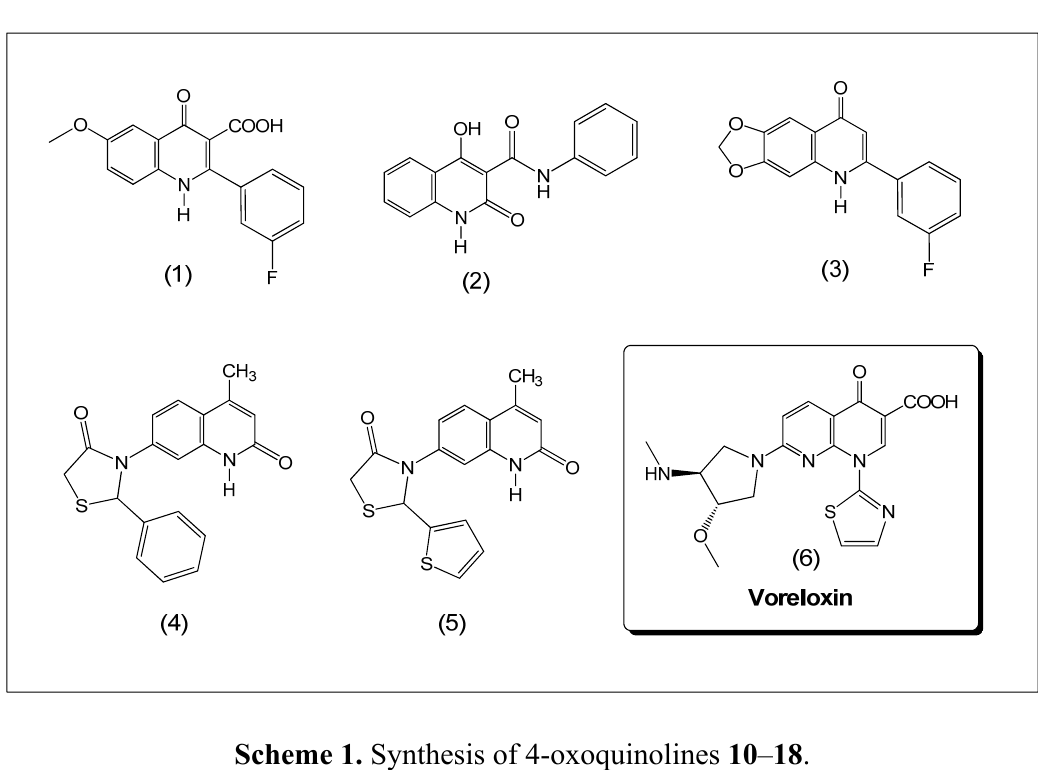
Figure 1. Structures of voreloxin ( 6 ) and several oxoquinoline derivatives 1 – 5 with anticancer